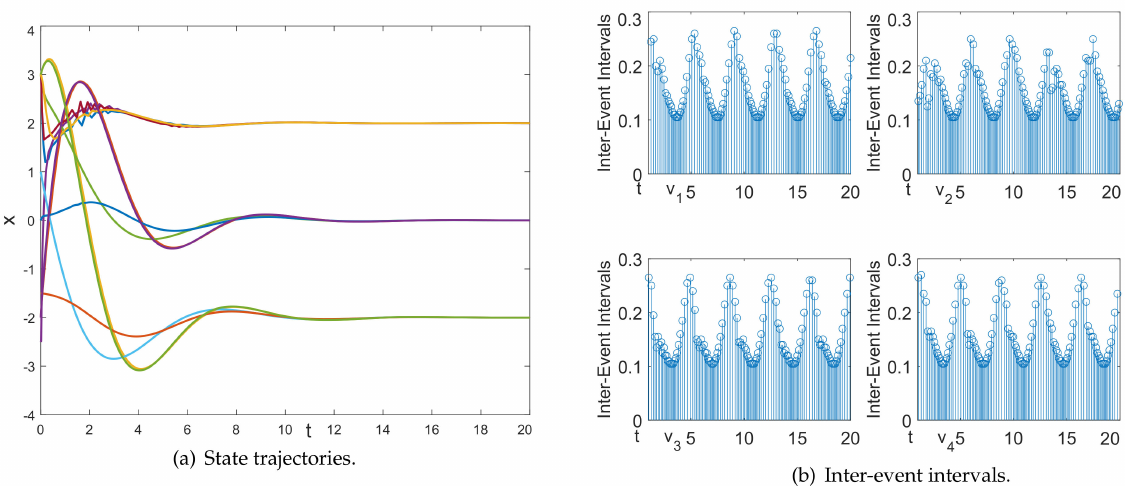
Figure 4. Integral–type edge-self-triggered policy in Algorithm